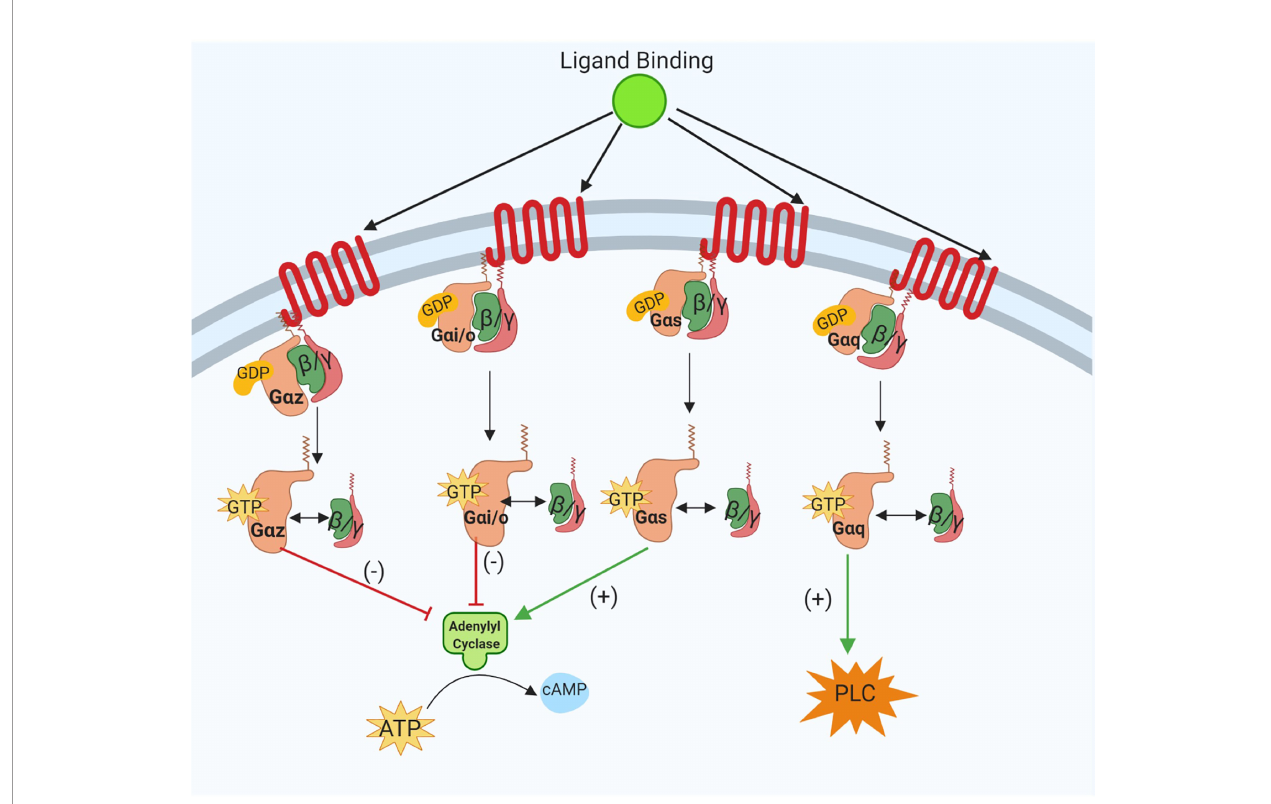
FIGURE 1 | Schematic representation of the canonical intracellular G a subunit signal transduction pathways activated following ligand binding at G-protein Coupled Receptors (GPCRs). The speci fi city of G a i/o, G a s, G a z, and G a q subunit activation in downstream signaling pathways is shown. As illustrated dissociation of G a z and G a i/o subunits reduces cyclic AMP (cAMP) and GTP-bound G a s increases intracellular cAMP levels. Activation of G a q subunits evokes increased phospholipase C (PLC) signaling activity. Image was generated using